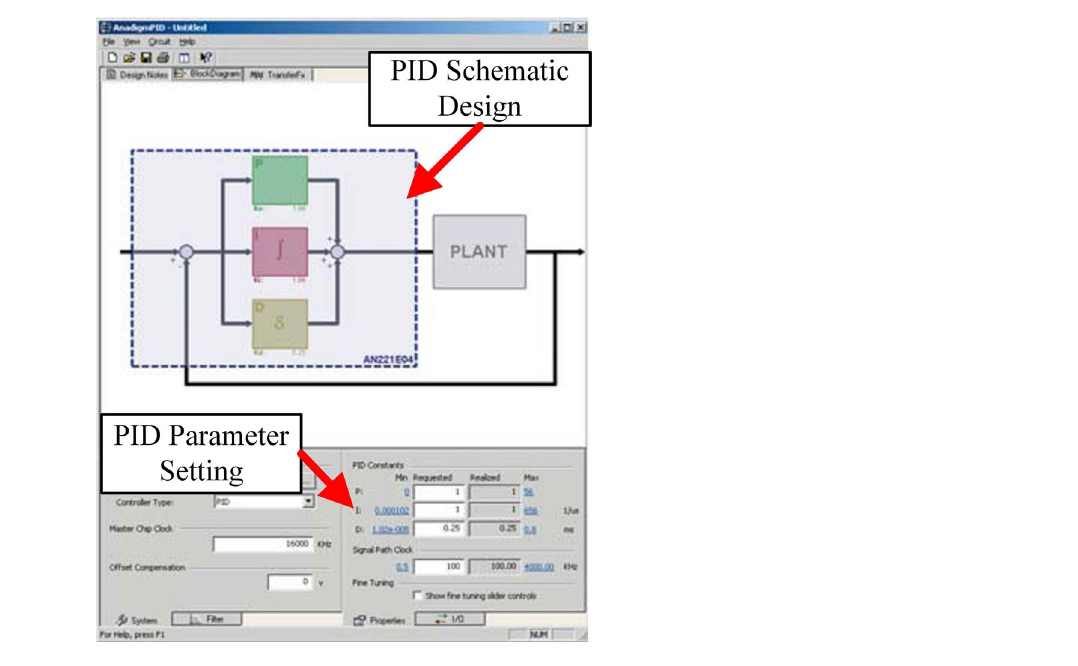
Figure 12. PID parameter setting